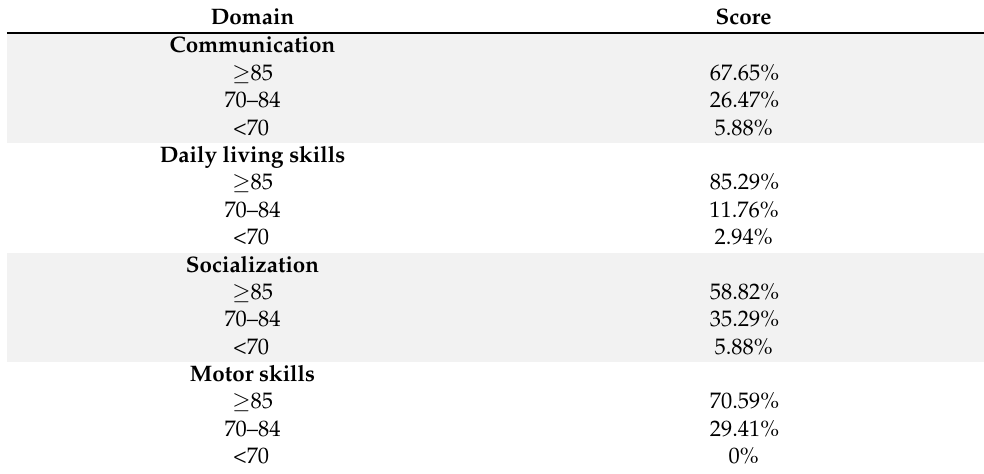
Table 4. Neurodevelopmental outcomes using the Vineland